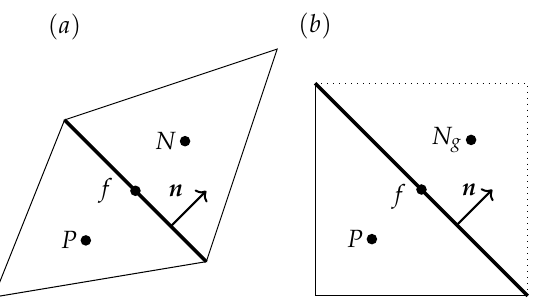
Figure 2. Schematic figure of ( a ) two cells P (parent) and N (neighbour) and ( b ) a boundary cell P with its ghost cell N g . f is the face between two cells and n defines the normal vector